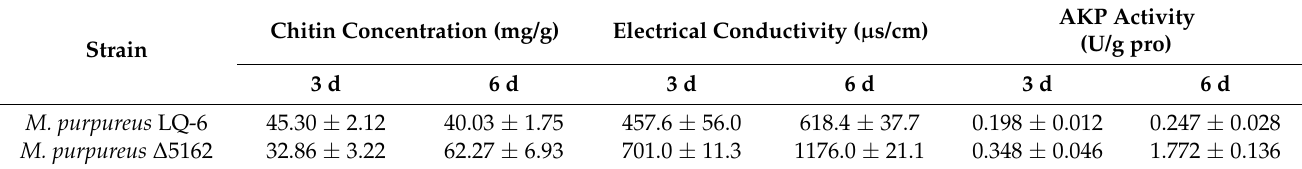
Table 1. Determination of M. purpureus LQ-6 and M. purpureus ∆ 5162 strains for chitin content and cell wall and membrane